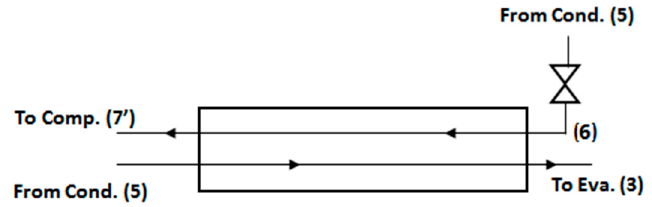
Figure 7. Heat exchange process in economizer.